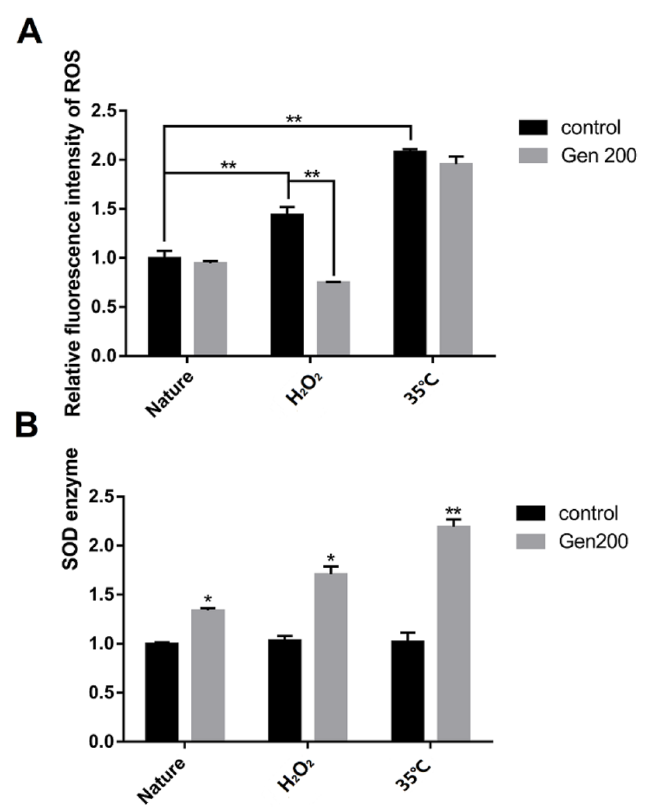
Figure 3. Under control, H 2 O 2 , and 35 ◦ C conditions, 200 µ M genistein influences ROS accumulation and the activity of superoxide dismutase (SOD) in the stage L4 C. elegans . ( A ) The effect of genistein on the accumulation of ROS in C. elegans under control, H 2 O 2 , and 35 ◦ C conditions. ( B ) The effect of genistein on the activity of SOD in C. elegans under control, H 2 O 2 , and 35 ◦ C conditions ( * p < 0.05; ** p < 0.01).